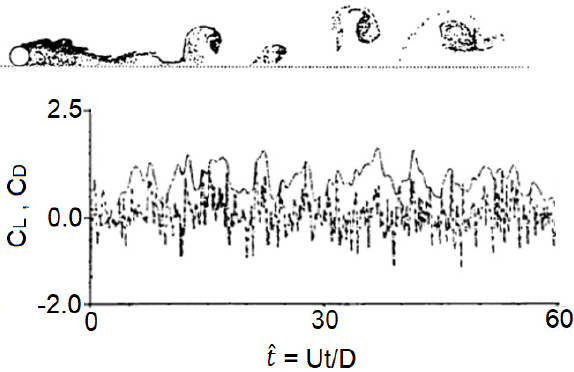
Figure 11. The flow pattern and force coefficients for G/D = 0.1 and Re = 100,000.